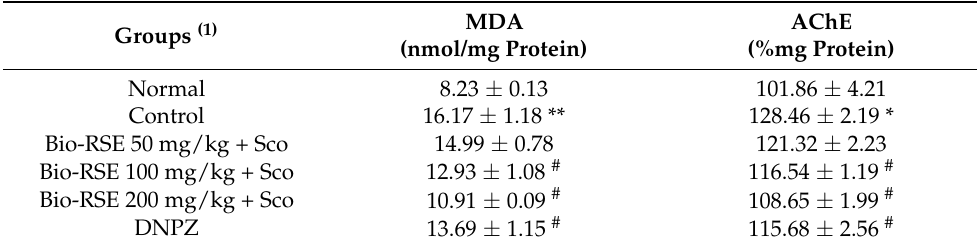
Table 6. Serum MDA levels and brain AChE activity in each